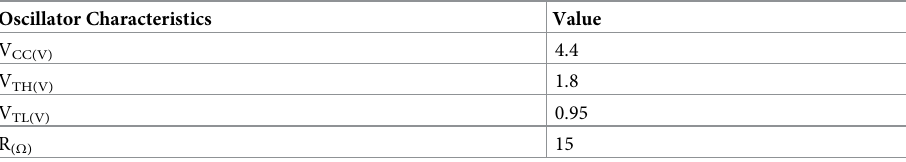
Table 2. Oscillator values.